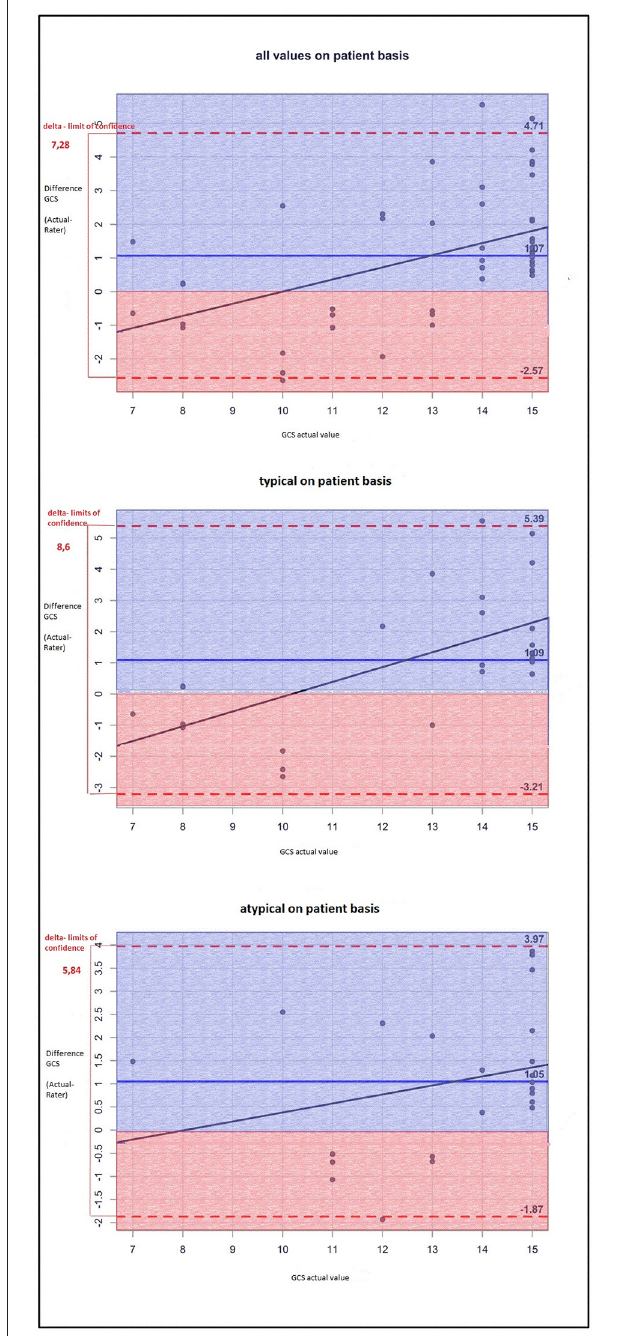
FIGURE 2 | The Bland-Altman-plot shows the difference between the actual and the estimated GCS scores (mean for all raters) on patient basis: On average, the estimated GSC score is too low by 1.07 without any significant differences between typical (i.e., deep) and atypical (i.e., lobar) ICH.